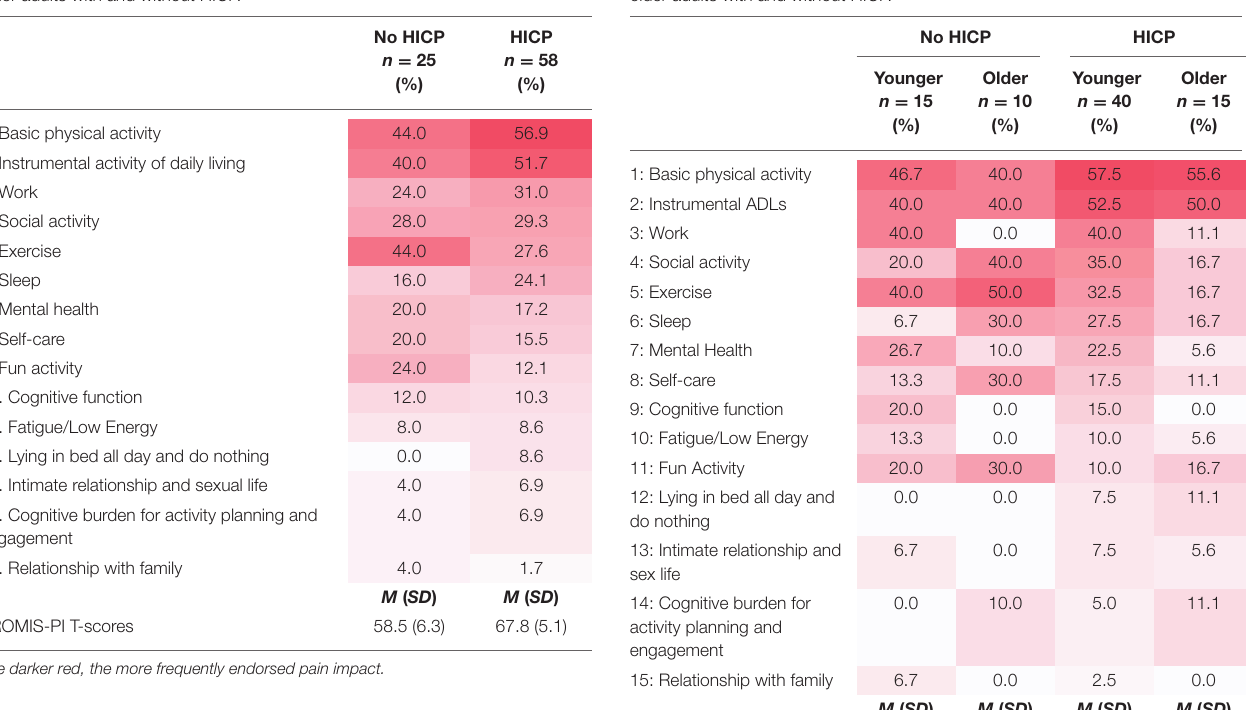
TABLE 5 | Comparing the three major areas of pain impact between adults and older adults with and without